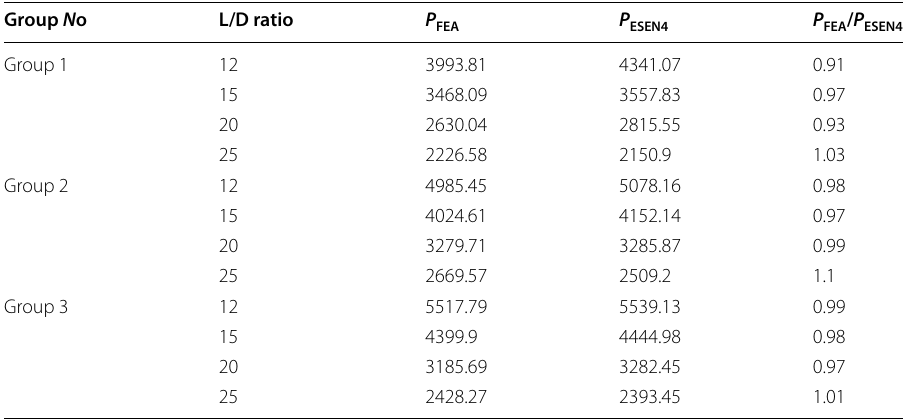
Table 4 Comparison of load carrying capacity between ABAQUS analysis and EBCS EN